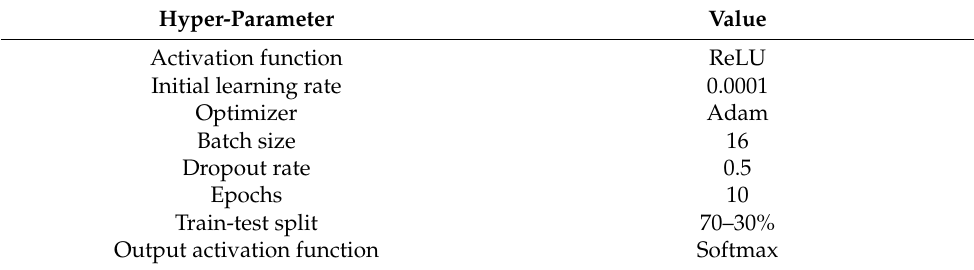
Table 2. Hyper-parameter values for training the Generic CNN